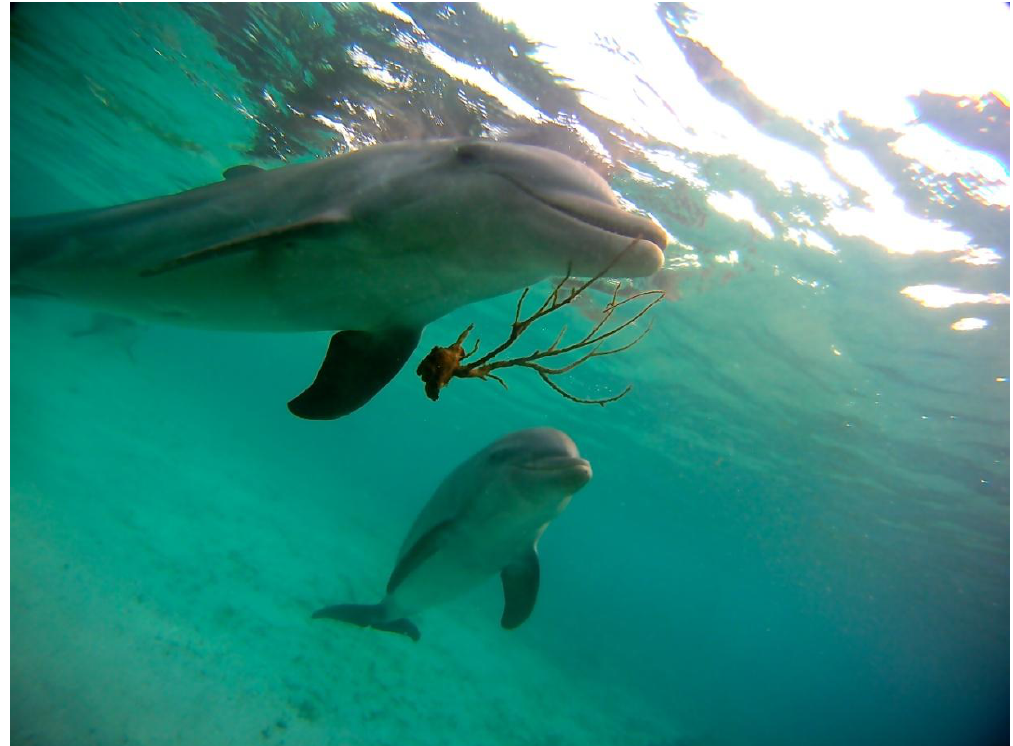
Figure 2 . A young dolphin plays with an object it found on the seabed while another dolphin